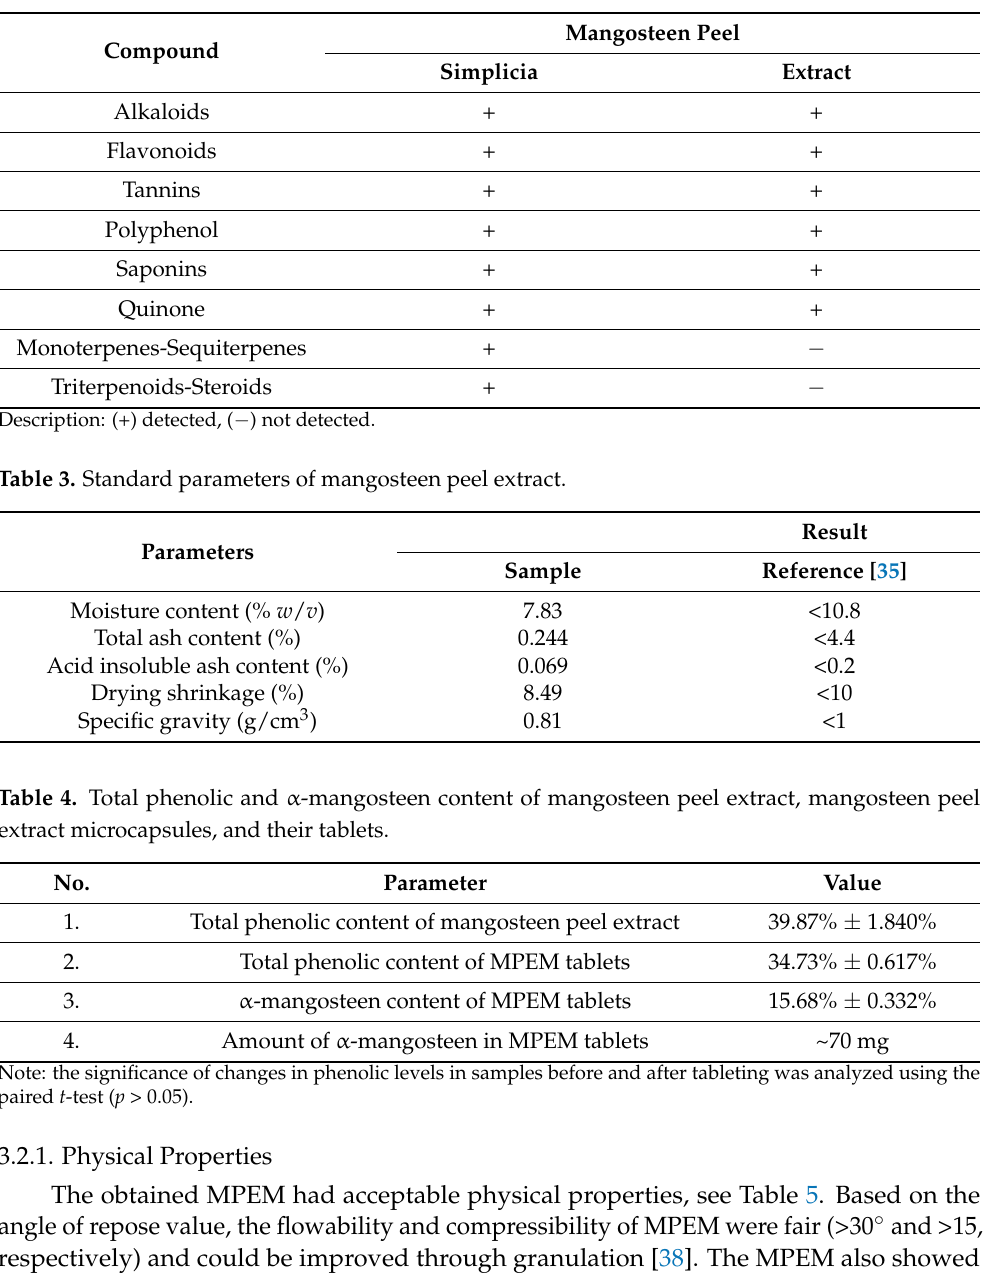
Table 2. Phytochemical contents of mangosteen peel extract. Compound Alkaloids Flavonoids